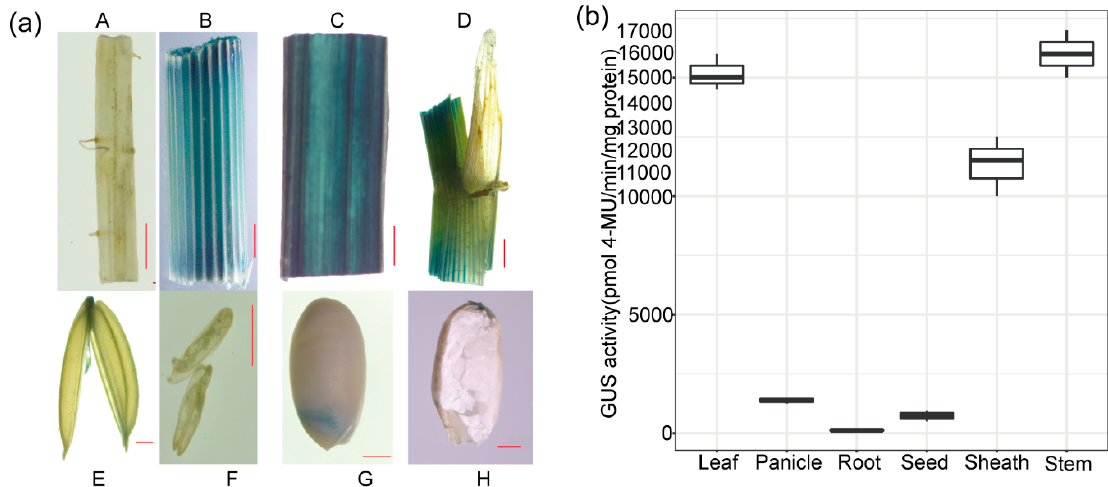
Figure 7. GUS histochemical assays and GUS activity in different tissues of OrGSEp-374 transgenic rice. ( a ) GUS histochemical assays of OrGSEp-374 transgenic rice. A. Root, B. stem, C. leaf, D. ligule, E. spikelet, F. anther, G. seed. H. endosperm. Bar = 1000 μ m; ( b ) GUS activity in different tissues of